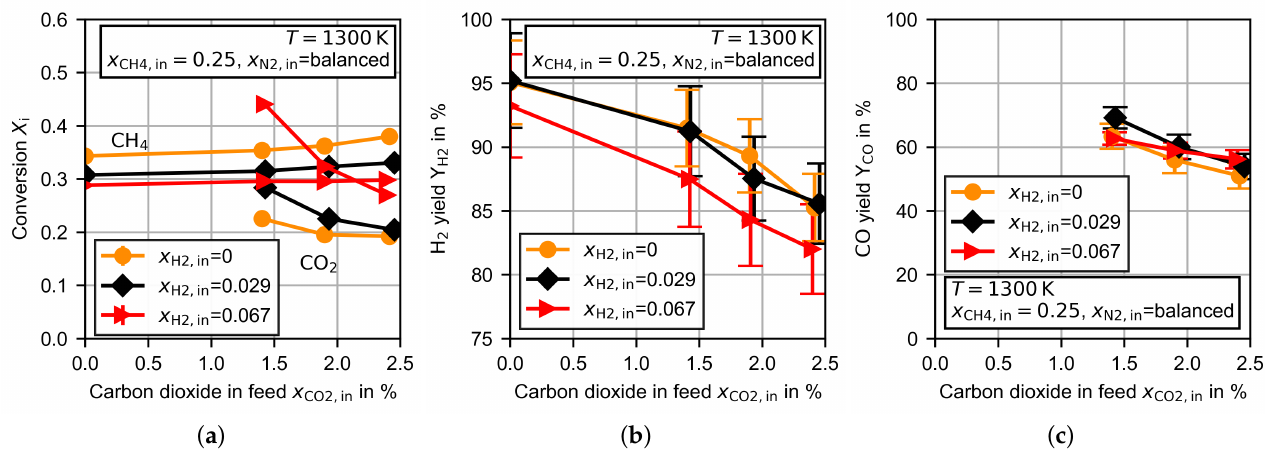
Figure 8. Experimental results for the TDM dependent on the molar fractions of hydrogen and carbon dioxide in the feed at 1300K at a constant flow rate of 1Nl/min. ( a ) Methane/carbon dioxide conversion, ( b ) hydrogen yield and ( c ) carbon monoxide